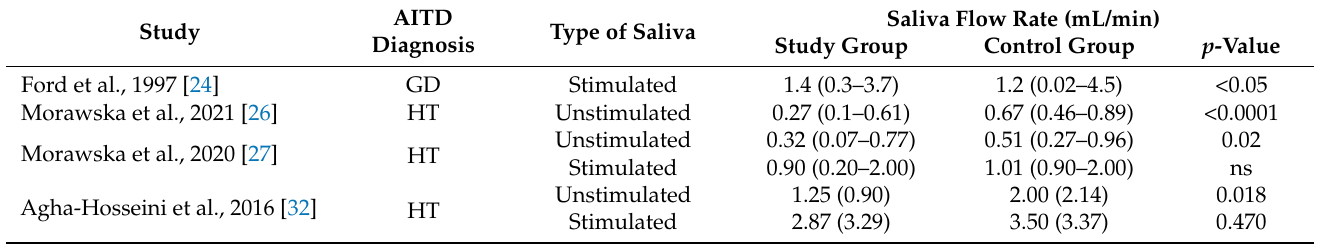
Table 5. Saliva flow rates reported in the included studies (data presented as medians with interquar- tile range or